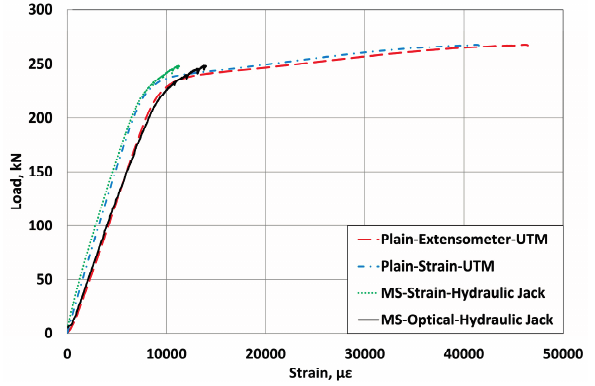
Figure 8. Load-strain curves of the sensing-strand (optical sensor and extensometer).